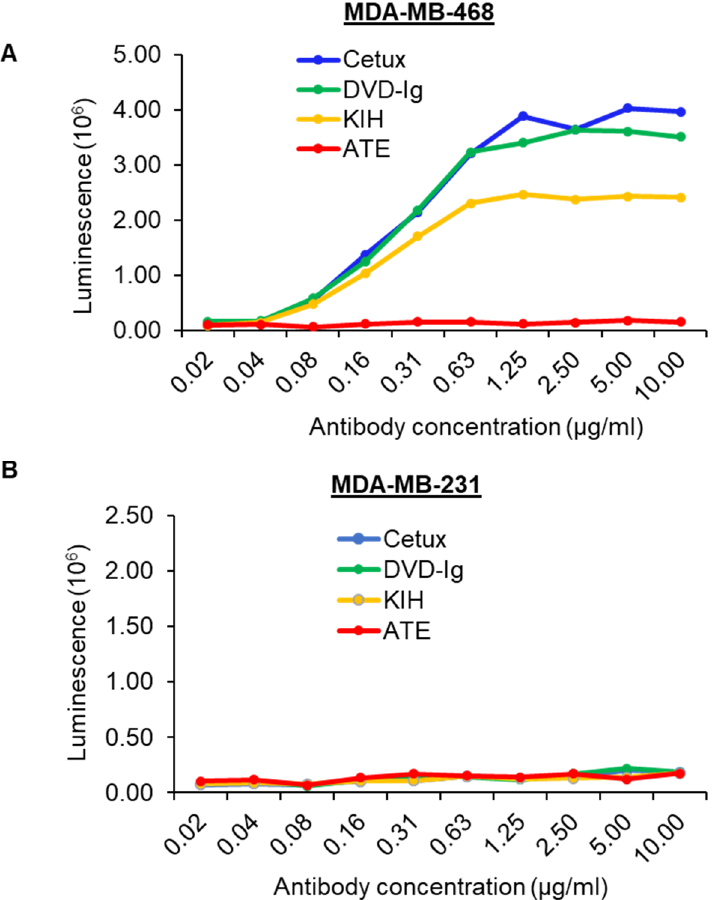
Figure 7. ADCC activity induced by anti-EGFR/PD-L1 BsAbs. ADCC activity was determined by ADCC Reporter Bioassay. Target cancer cells MDA-MB-468 ( A ) and MDA-MB-231 ( B ) were seeded in 96-well plates and incubated with serially diluted antibodies and effector cells for 5–6 h. Bio-Glo™ Luciferase Assay Reagent was added to the plates and luminescence was measured using GloMax discover plate